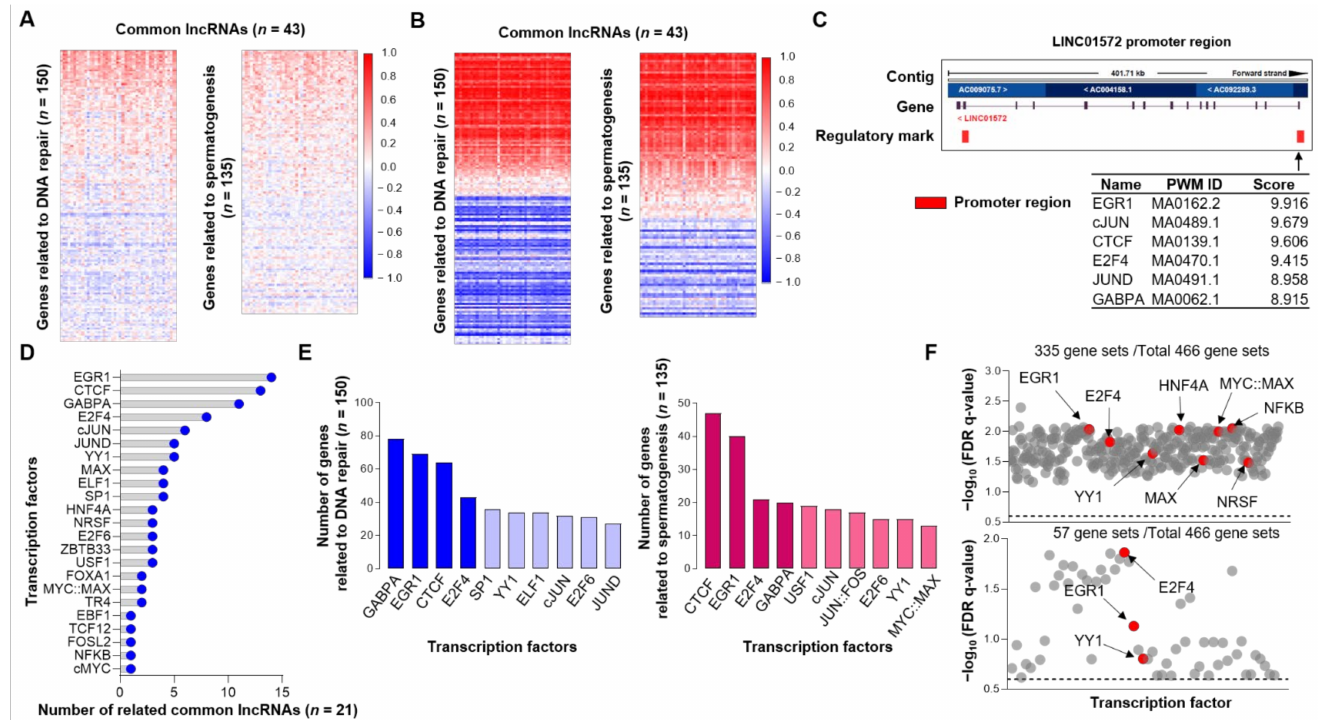
Figure 5. Identification of common transcription factors for Notch-related lncRNAs and genes related to DNA repair and spermatogenesis. ( A ) Correlation analysis of common lncRNA clusters with genes related to DNA repair and spermatogenesis using data from TCGA OVCA and ( B ) our siRNA experiments. ( C ) Representative result of ENCODE predicting putative transcription factors. ( D ) Re- sults from ENCODE using 21 out of 43 common lncRNAs presenting number of lncRNAs associated with putative transcription factors. ( E ) Results from ENCODE using genes related to DNA repair and spermatogenesis presenting number of genes associated with putative transcription factors. ( F ) Transcription factors that are up- or down-regulated according to NOTCH1/3 status. GSEA was performed using legacy subset of transcription target gene sets as described in the Methods section. Upper and lower panels presented the results of GSEA using TCGA OVCA and our tran- scriptome data, respectively. The legacy subset of transcription target gene sets originally supported 610 gene sets, but we excluded unknown transcription factor and applied gene set size filter (min = 15, max = 500), and finally used 466 gene sets. Each dot represents one transcription target gene set which showed adjusted p -value < 0.05 and FDR q-value < 0.25. The dotted line indicates FDR = 0.25. Abbreviations: EGR1, Early Growth Response 1; CCTF, CCCTC-Binding Factor; GABPA, GA Binding Protein Transcription Factor Subunit Alpha; E2F4, E2F Transcription Factor 4; FDR, False discovery